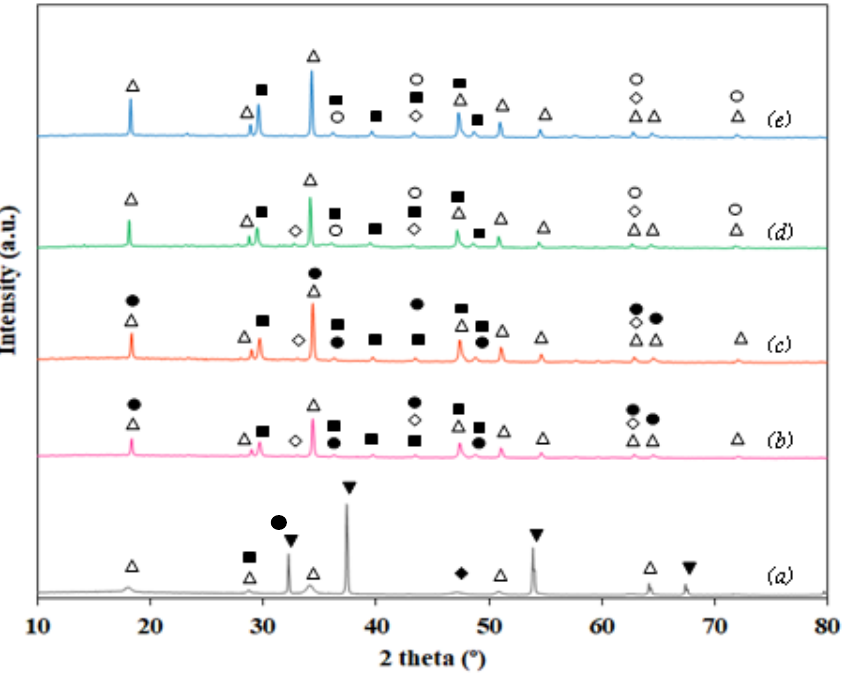
Figure 1. XRD patterns between 10 and 80 of ( a ) calcined eggshell, ( b ) Fe 5%, ( c ) Fe 15%, ( d ) Cu 5%, and ( e ) Cu 15%. Symbols: Ca(OH)₂ ( ), CaCO₃ ( ), CaO ( ▼ ), MgCO₃ ( ), MgO ( ), Fe₂O₃ ( ), and CuO ( ).